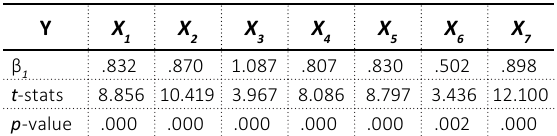
Table 1. Summary of results based on step 1: